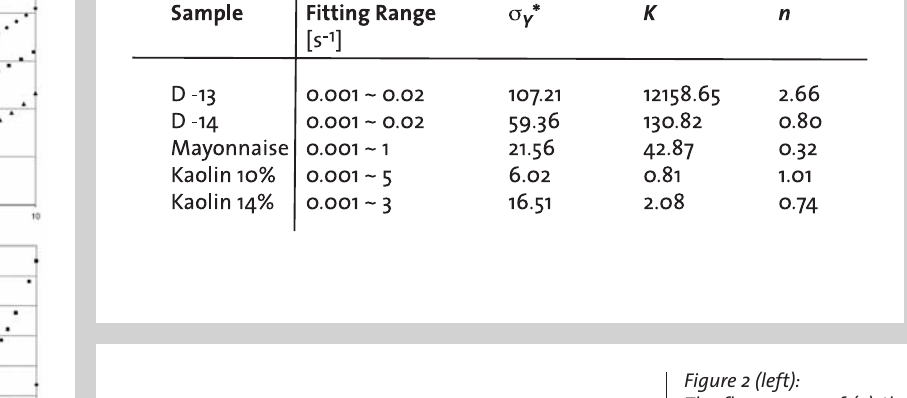
Figure 2 (left): The flow curves of (a) three different emulsions (two explosive and a mayonnaise) and (b) two different suspen- sions. Table 2 (right): Values of Herschel-Bulkley model fitted on different